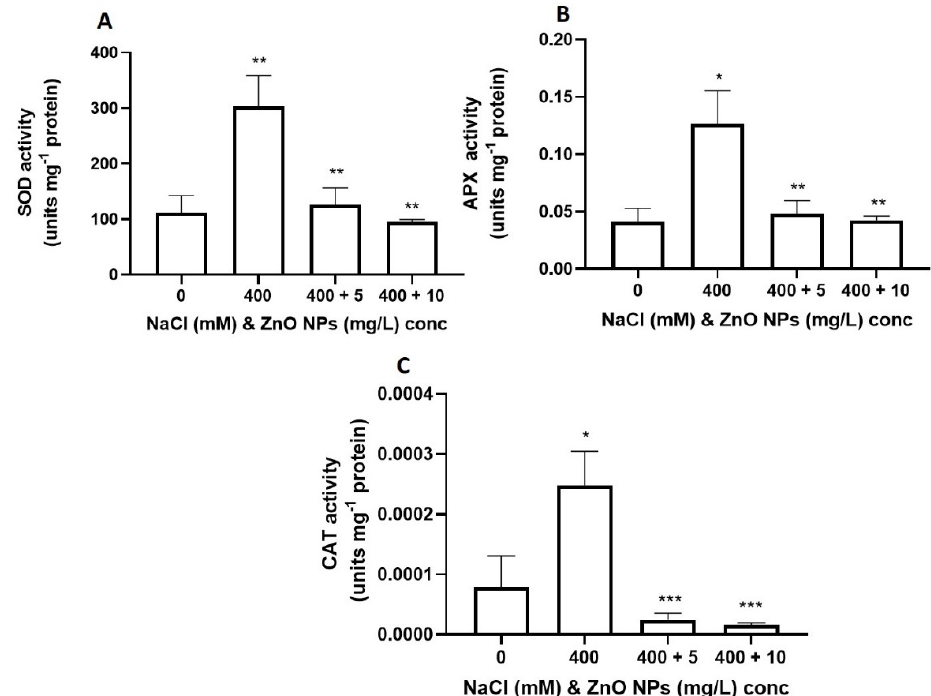
Figure 6. Effect of salt and the priming of ZnO NPs on the antioxidant enzyme activities of sorghum. ( A ) Superoxide Dismutase, ( B ) Ascorbate peroxidase and ( C ) Catalase activity in salt-treated plants, and those primed with ZnO NPs. Error bars represent the SD calculated from three biological replicates. Statistical significance between control and treated plants was determined by a two-way ANOVA performed on GraphPad 9.0, shown as *** = p ≤ 0.001, ** = p ≤ 0.01, and * = p ≤ 0.05 according to the Bonferroni’s multiple comparisons test.